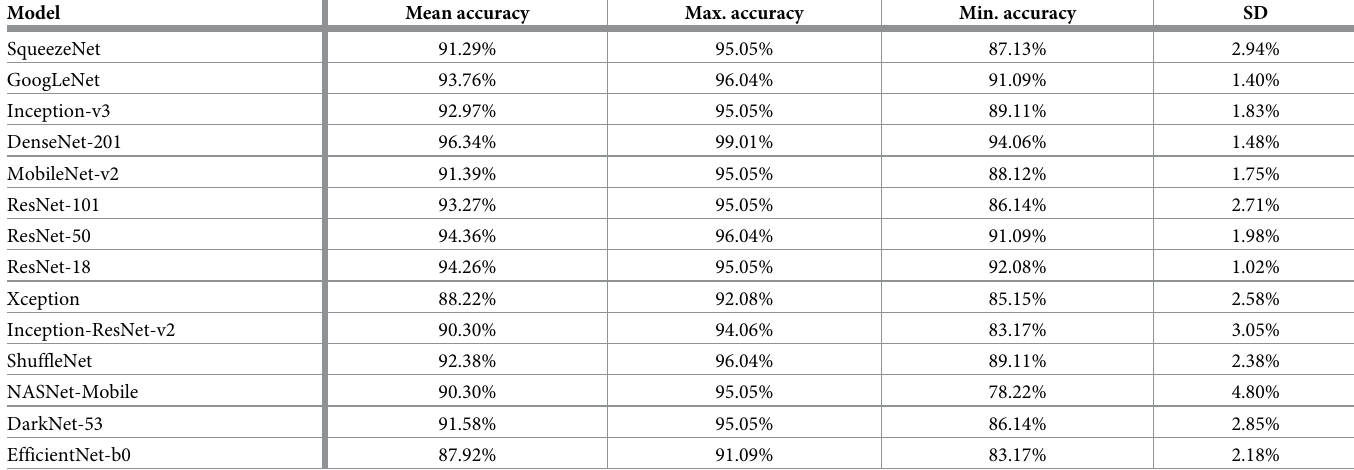
Table 1. The accuracy of classifying X-ray images into three classes; normal, scoliosis, or spondylolisthesis, for each deep learning model. The results are reported for 40 runs of each model. SD stands for standard deviation.